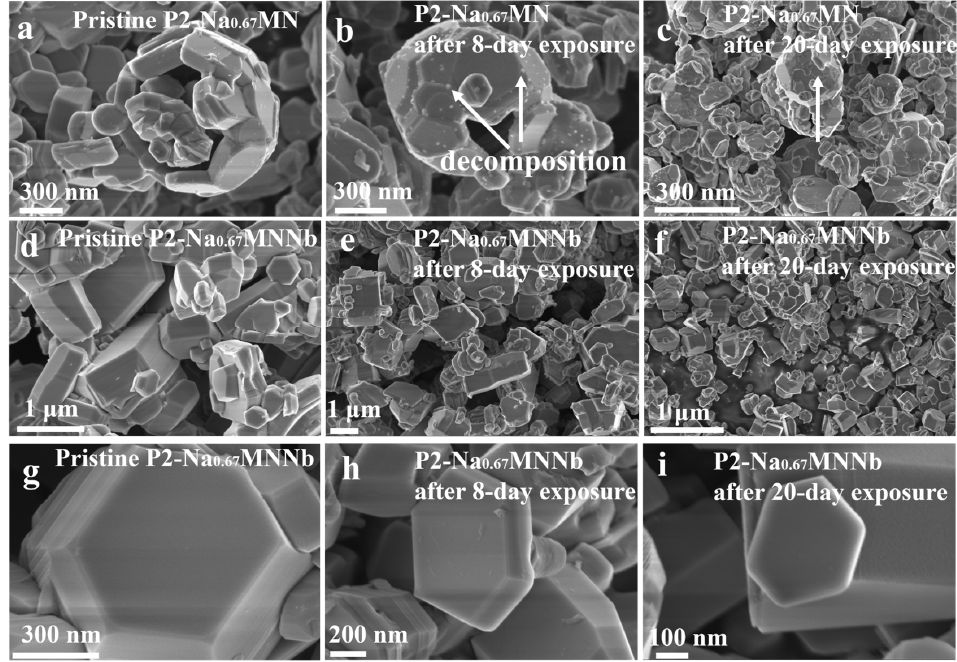
Figure 3. The SEM images of ( a ) pristine P2-Na 0.67 MN and ( b , c ) P2-Na 0.67 MN samples exposed in RH93% humid environment after di ff erent days of exposure. The SEM images of ( d , g ) pristine P2-Na 0.67 MNNb. ( e , h ) P2-Na 0.67 MNNb samples exposed in RH93% humid environment after 8 days of exposure. ( f , i ) P2-Na 0.67 MNNb samples exposed in RH93% humid environment after 20 days of exposure.